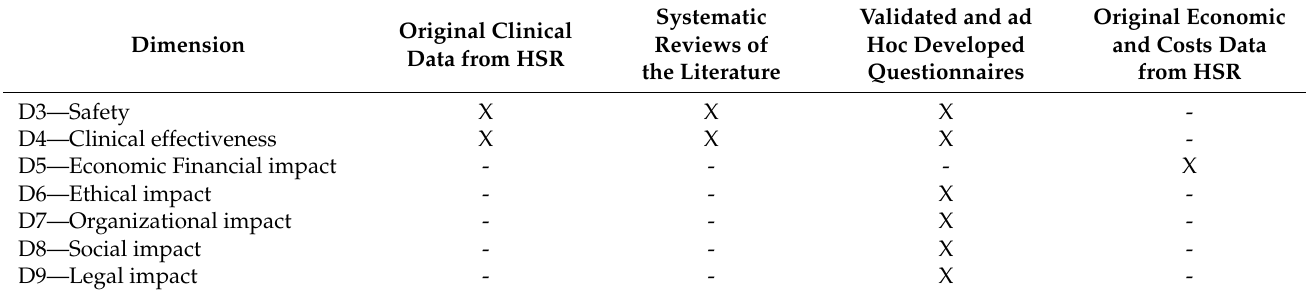
Table 1. Data sources used for each